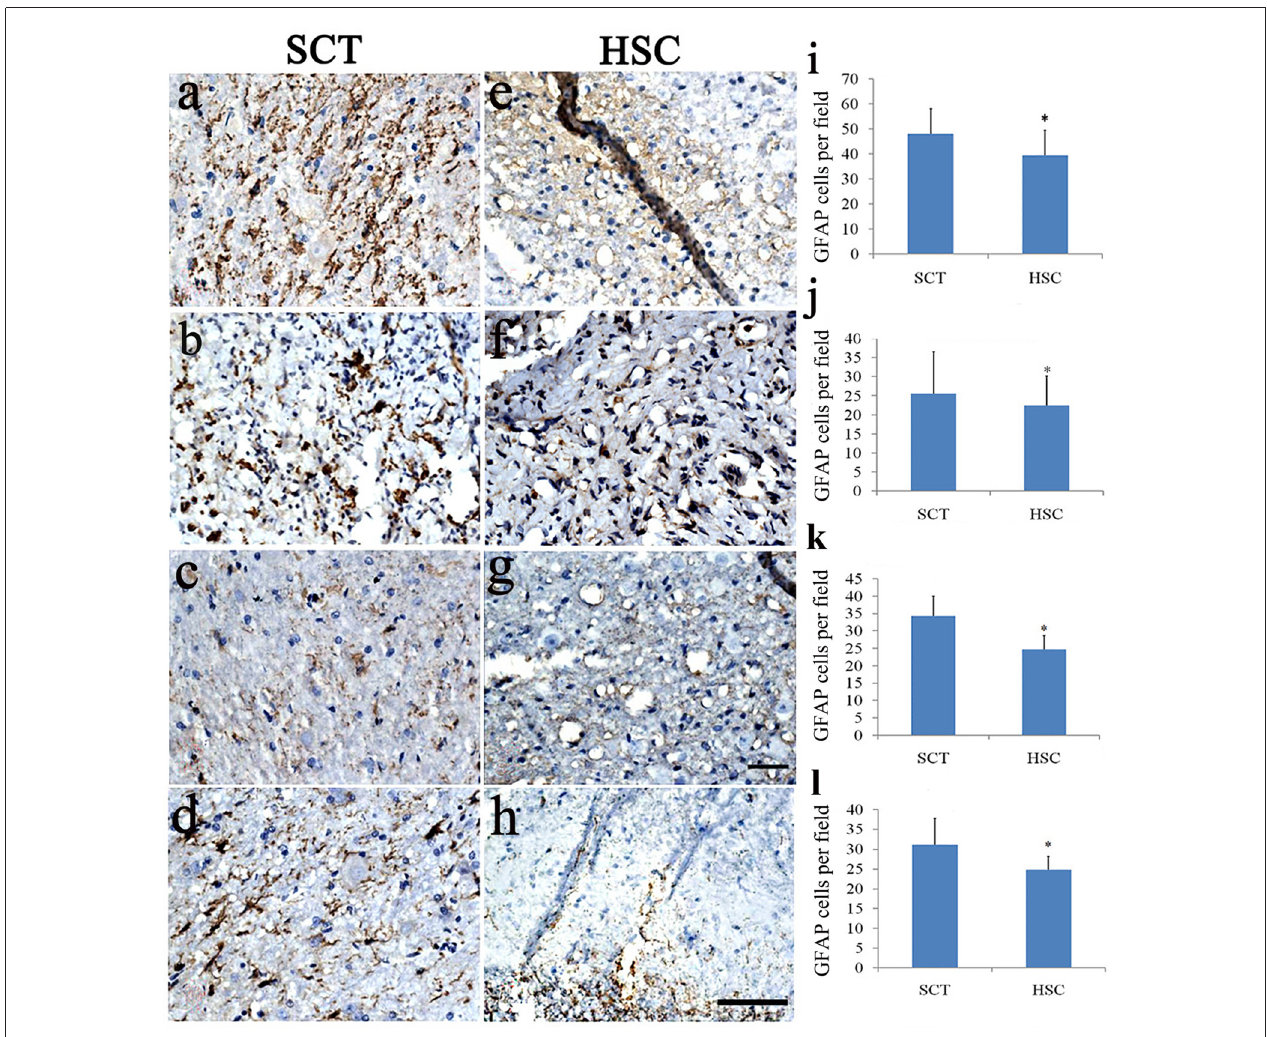
FIGURE 8 | HSC transplantation decreased the number of astrocytes. SCT greatly increased the number of GFAP + cells in the rostral, scar and caudal sites of the transected cord (A–D) . While HSCs transplantation effectively impressed the number of astrocytes in these segments (E–H) . Histogram showed that the number of astrocytes in HSC transplanted group was lower than that of SCT one (I–L) . (A,E,I) Scar center; (B,F,J) Posterior Funiculus of rostral scar; (C,G,K) gray matter of rostral scar; (D,H,I) Dorsal horn of caudal scar. Data are presented as the mean ± SD ( n = 7). Student’s t test was used to analyze the data. Data in the sham group were not shown. ∗ P < 0.05 vs. SCT. Bar = 50 µ